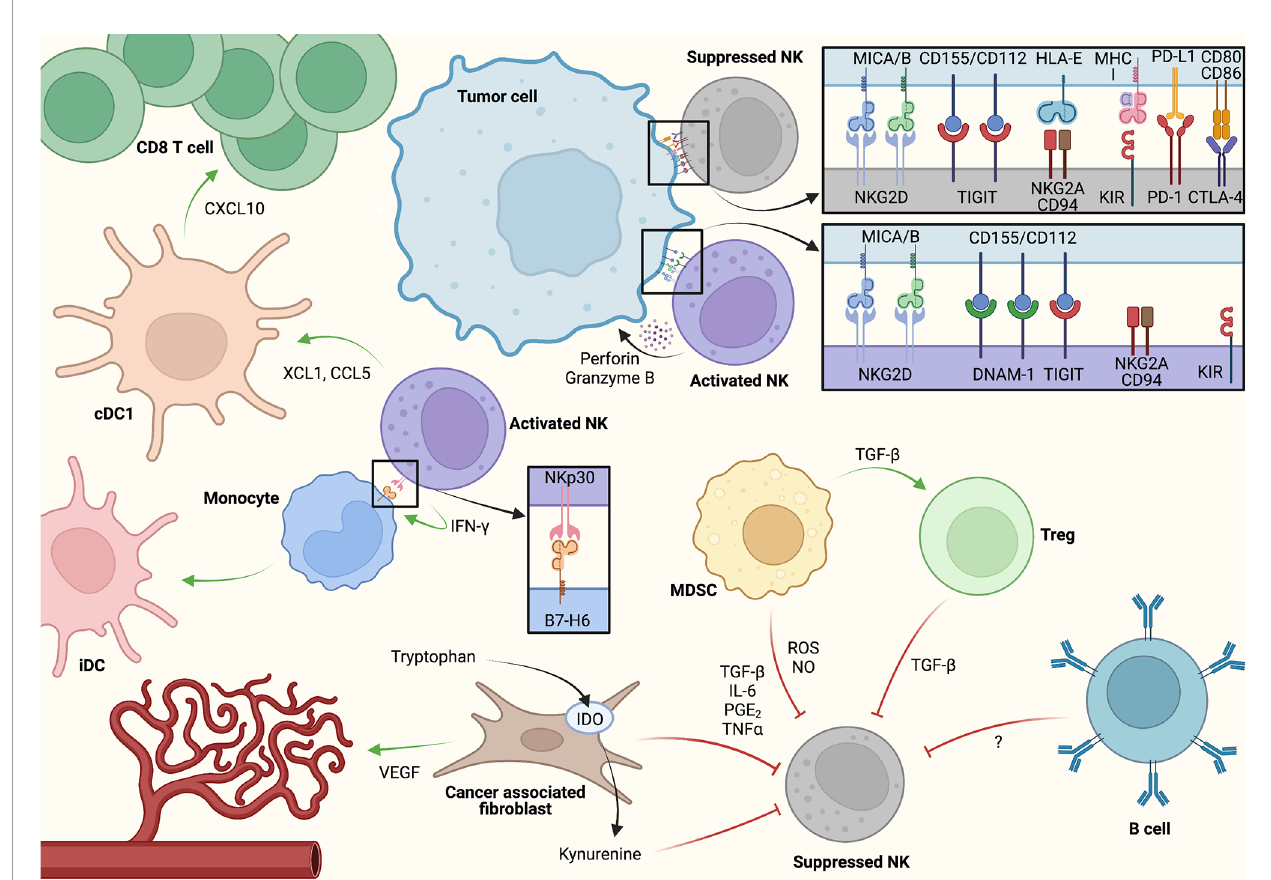
FIGURE 2 | A model for cell-cell interactions and key signaling molecules associated with NK cell activation and inhibition within the tumor microenvironment (TME). NK cells may induce adaptive antitumor immunity via direct conventional dendritic cell (cDC1) activation as well as through monocyte polarization toward in fl ammatory dendritic cell (iDC). At the same time, immunosuppressive crosstalk between cancer-associated fi broblasts (CAFs), myeloid-derived suppressor cells (MDSCs), regulatory T cells (Tregs), and potentially B cells/B regulatory cells through soluble factors restrain antitumor NK cell activity. Created using